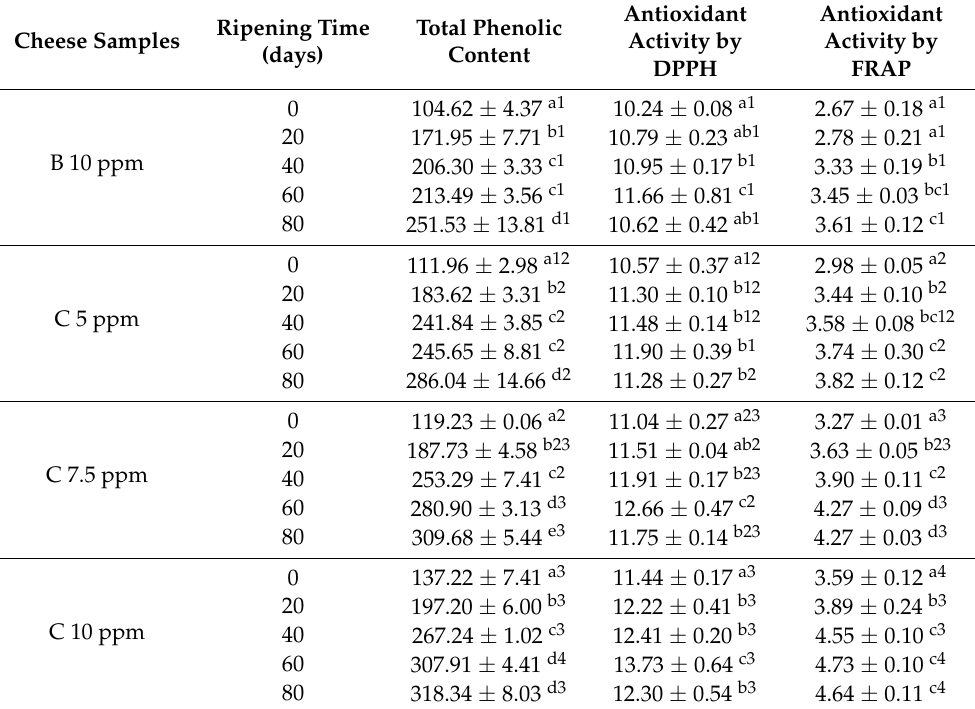
Table 2. Total phenolic content and antioxidant activity (evaluated by the FRAP and DPPH assays) in the manchego-style cheeses at different ripening